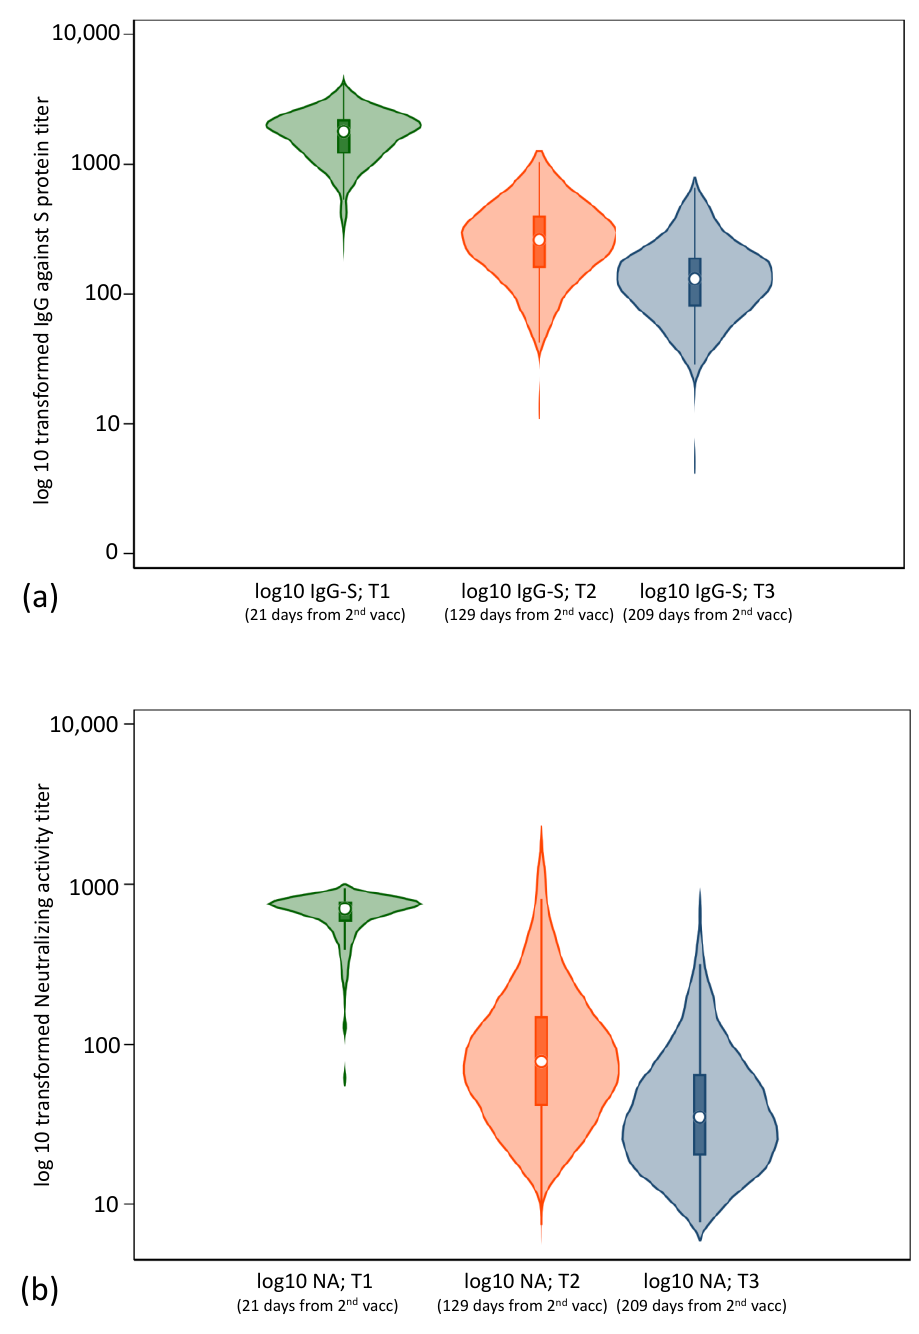
Figure 3. Common log-transformed antibody titers. ( a ) Violin plot showing the common log-transformed IgG against the S protein. ( b ) Violin plot showing the common log-transformed neutralizing activity.